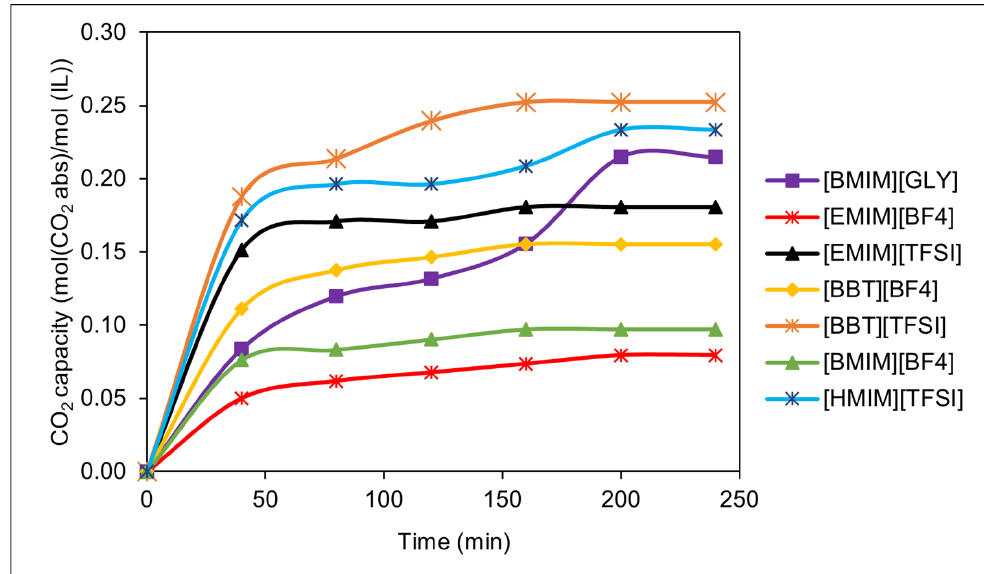
Figure 3. The amount of mole CO 2 absorbed/mole IL.